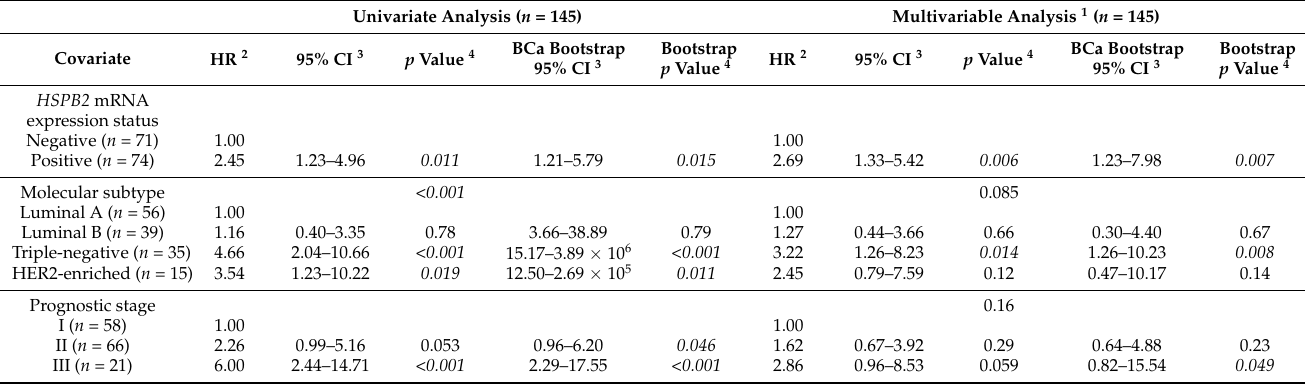
the estimated HR. 4 Statistically significant p values are shown in italics.